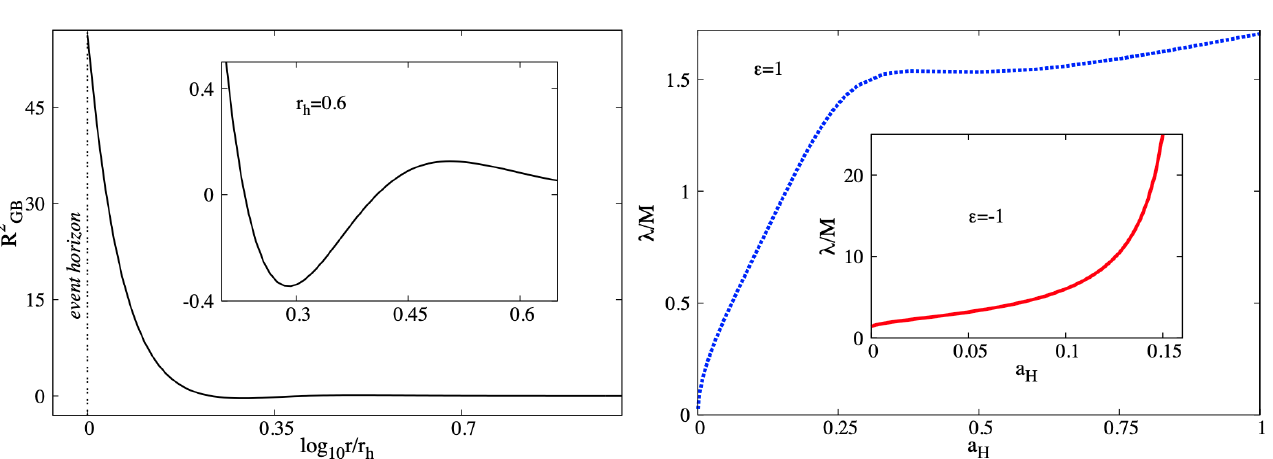
Figure 7. ( Left panel ) GB invariant as a function of the radial coordinate for an EYM BH with horizon radius r h = 0.6. One < 0, located outside the horizon. ( Right panel ) λ / M of the set of EYM BHs supporting scalar notices a shell with R 2 GB clouds as a function of the reduced horizon area for (cid:101) = ±